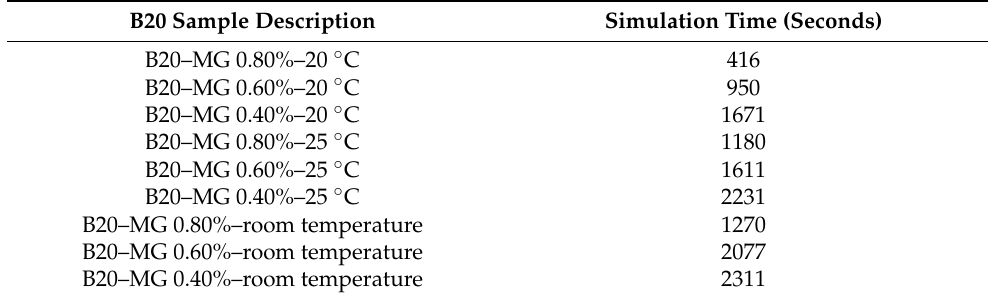
Table 8. Simulation time for each sample of B20 fuel with added powder impurity.